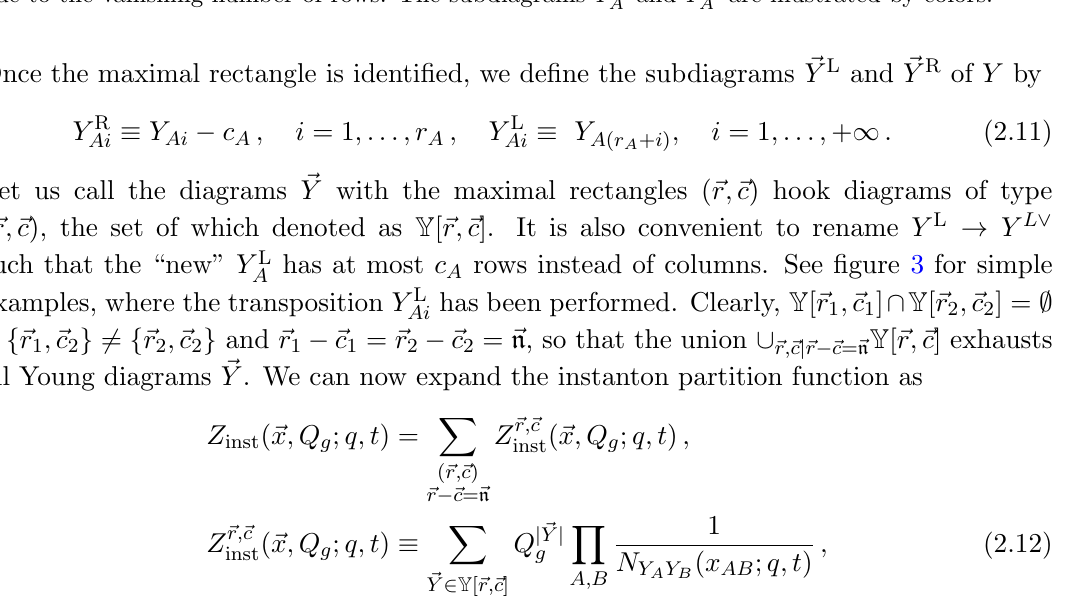
Figure 3 . Examples of hook diagrams of various types with their maximal rectangles in white of shape r A c A , such that n A r A c A = 2. In the (cid:12)rst example, the maximal rectangle is (cid:2) (cid:17) (cid:0) (cid:0)